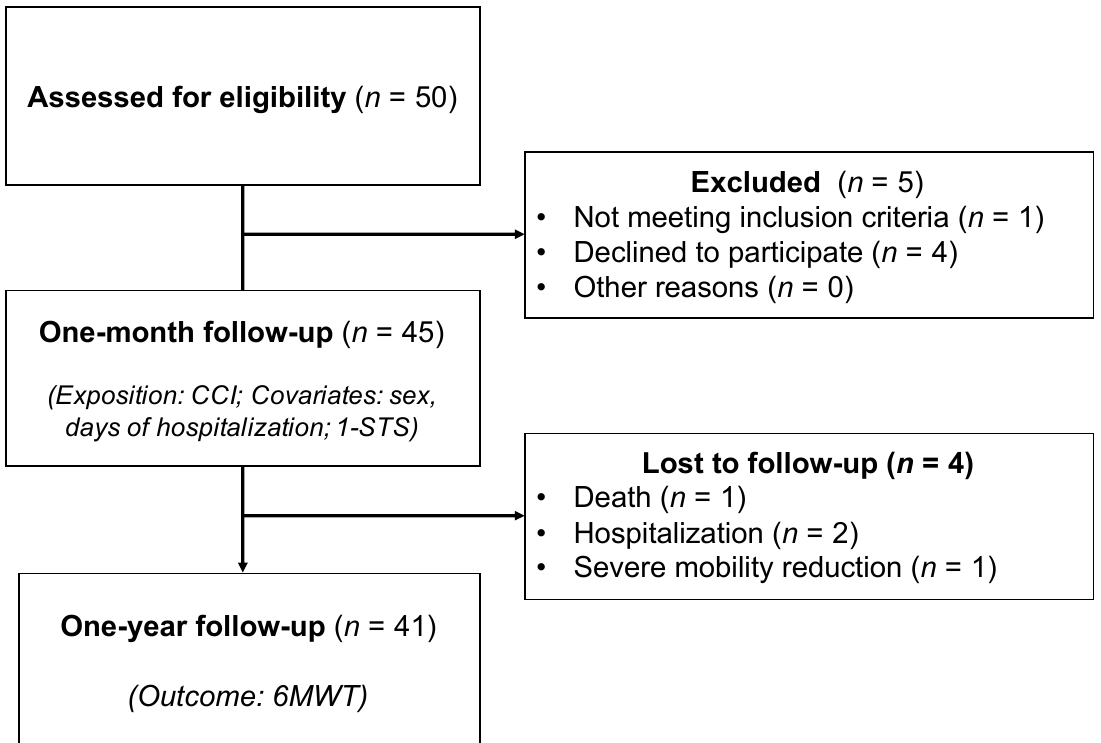
Figure 1. Patient flow diagram. Abbreviations : 1-STST: 1-min sit-to-stand; 6MWT, 6-min walk test; CCI: Charlson comorbidity index. Table 1. Patient characteristics.